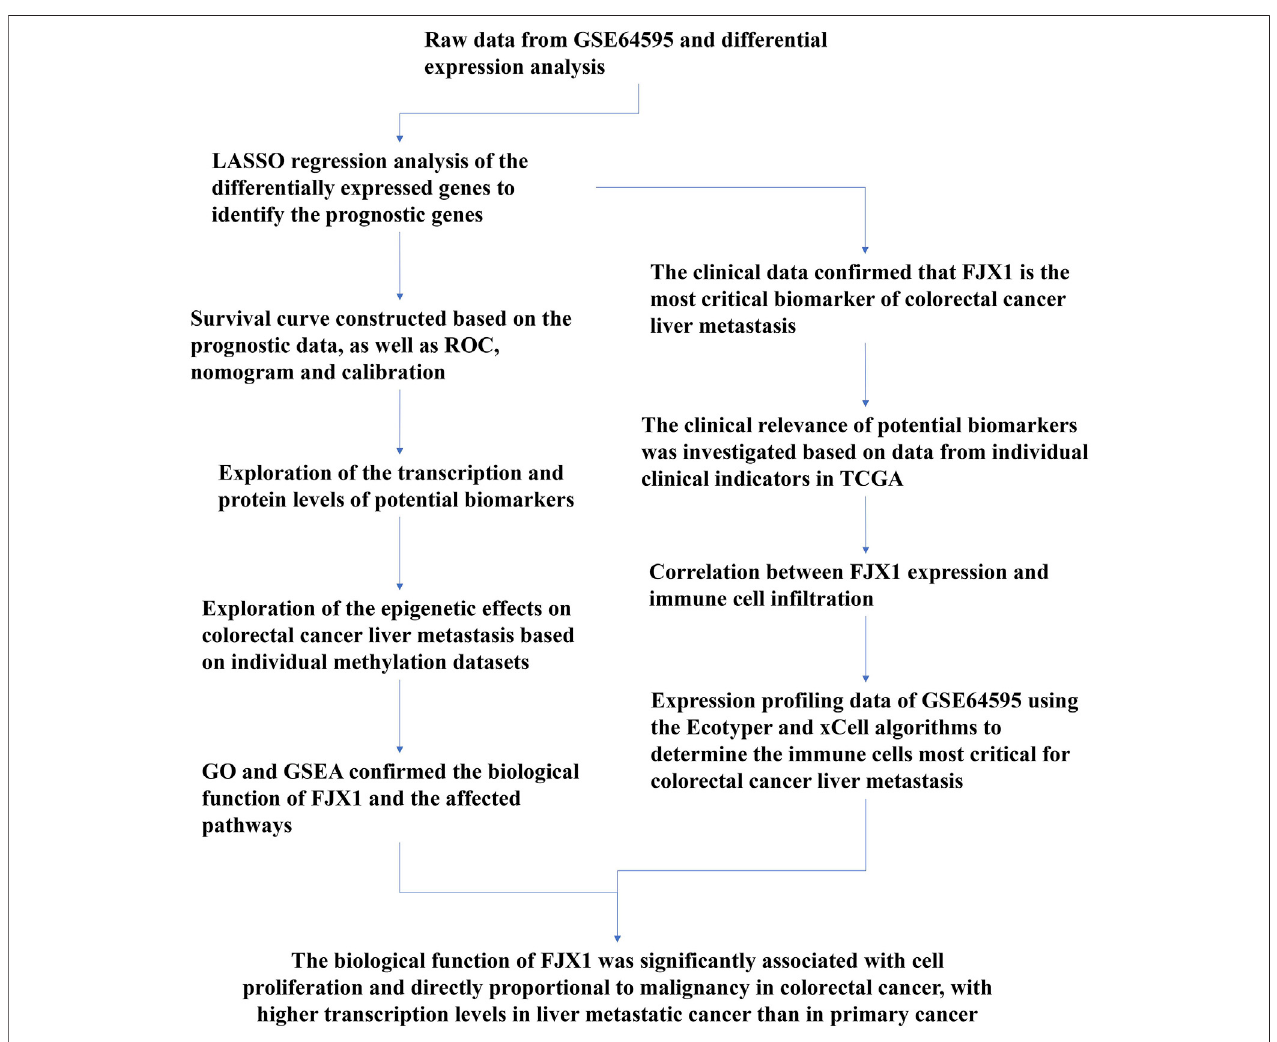
FIGURE 1 | Study fl ow